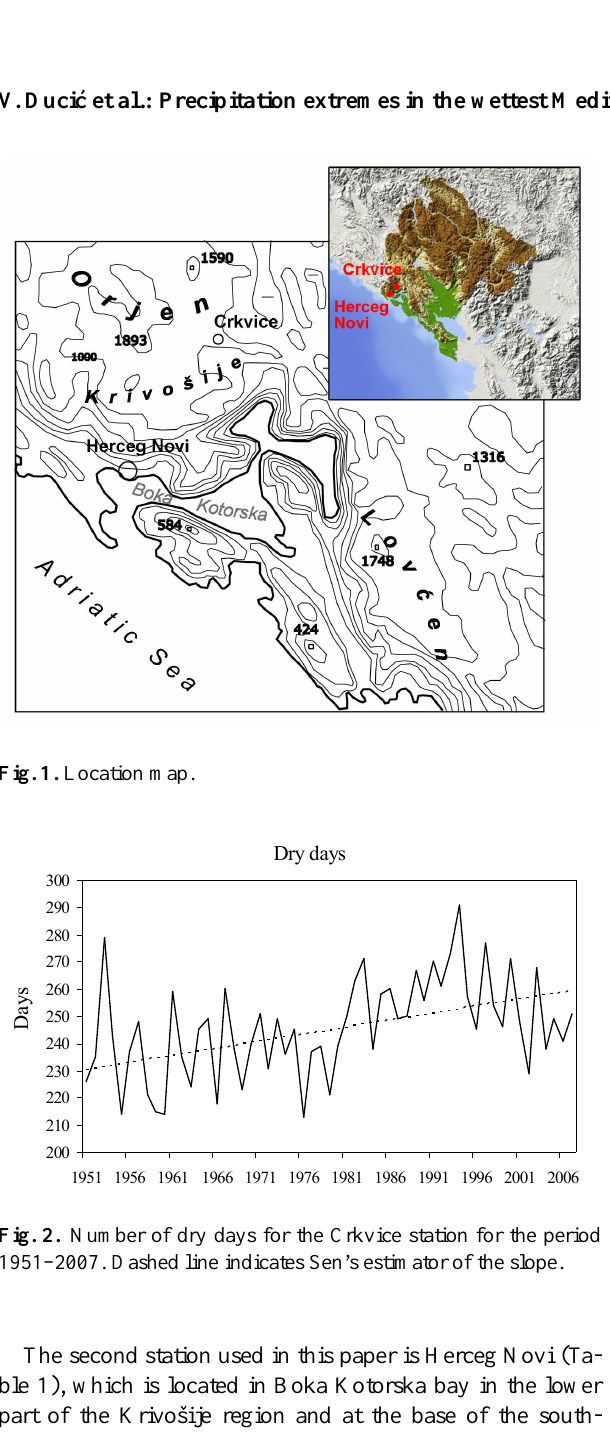
Fig. 5. Fraction of precipitation amount due to very wet days (R95pTOT) for the Crkvice station for the period